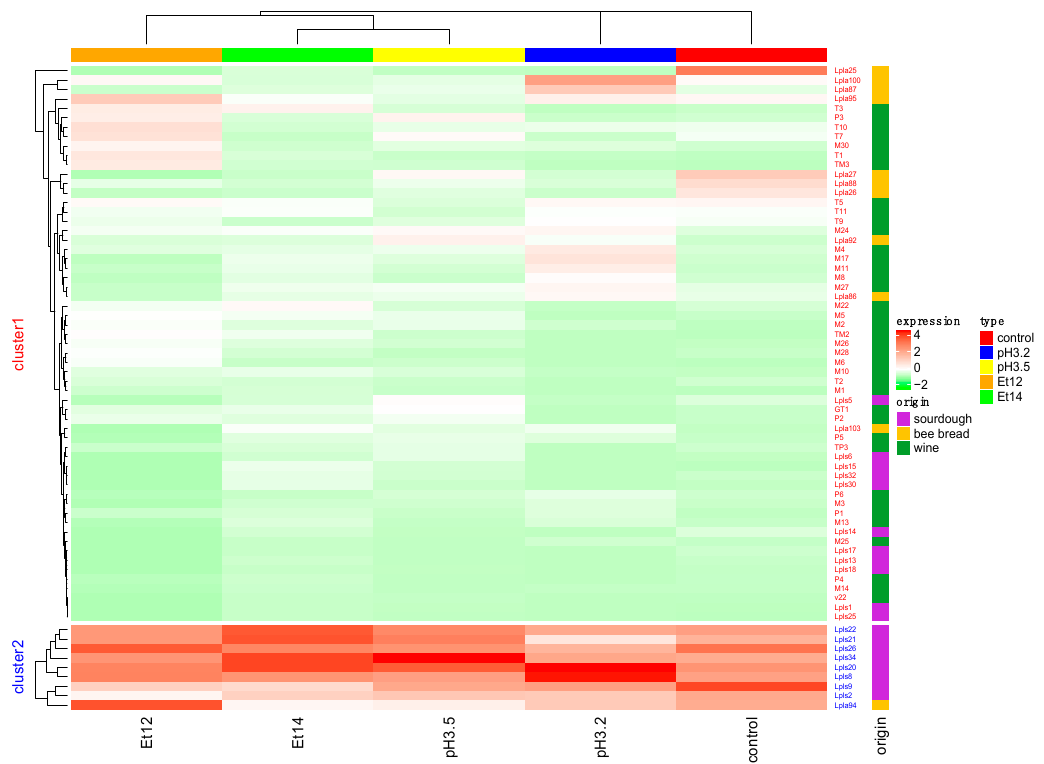
Figure 1. Heat-map related to the production of biofilm (expression) determined on 68 L. plantarum strains from different matrices (origin). The strains were grown for 24 h at 28 °C under different stress conditions (type): in Man Rogosa Sharpe (MRS) broth (control), in MRS broth at pH 3.5 (pH 3.5), in MRS broth at pH 3.2 (pH 3.2), and in MRS broth containing ethanol at 12% (Et12) or ethanol at 14% (Et14).